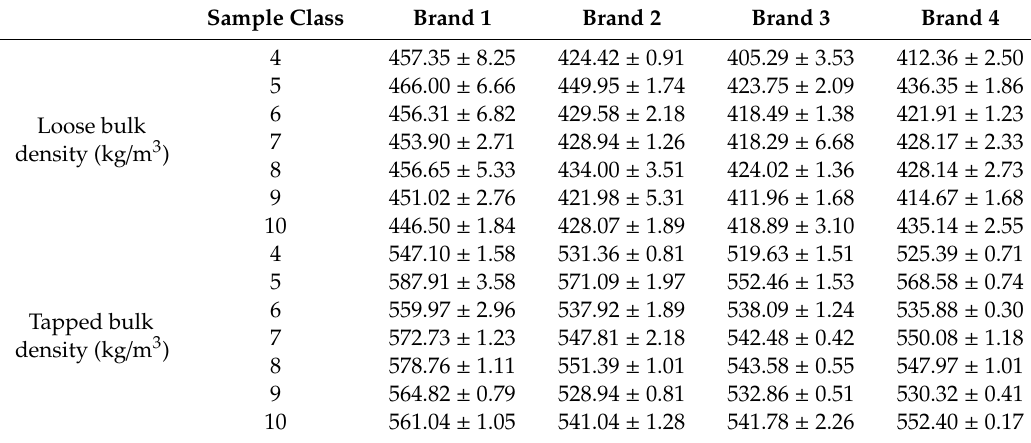
Table 2. Tapped and loose bulk density of each sample class for the four di ff erent brands. Sample Class